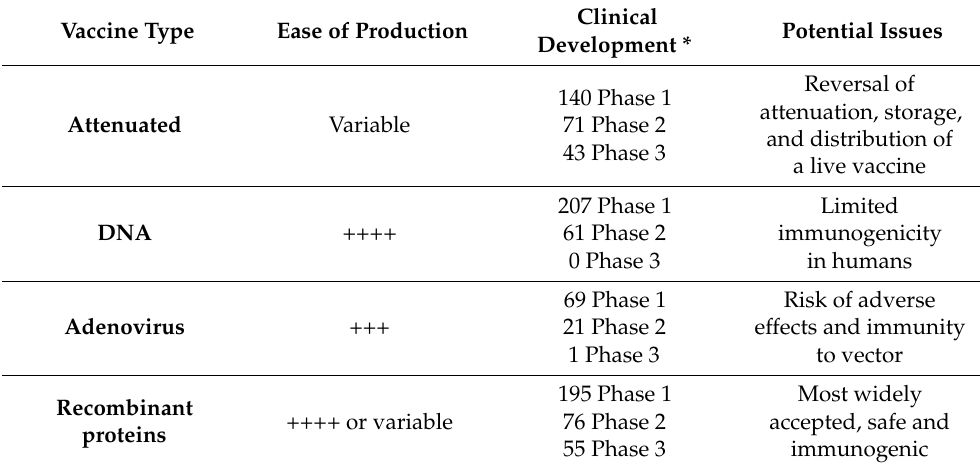
Table 2. Production and Clinical Development of Vaccines against Infectious